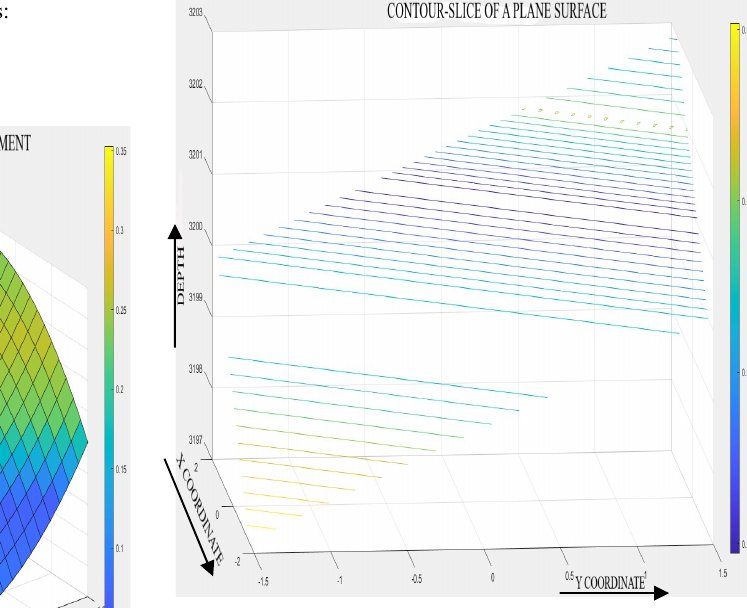
Figure 9. Contour-slice of a plane surface showing porosity variation (displayed on